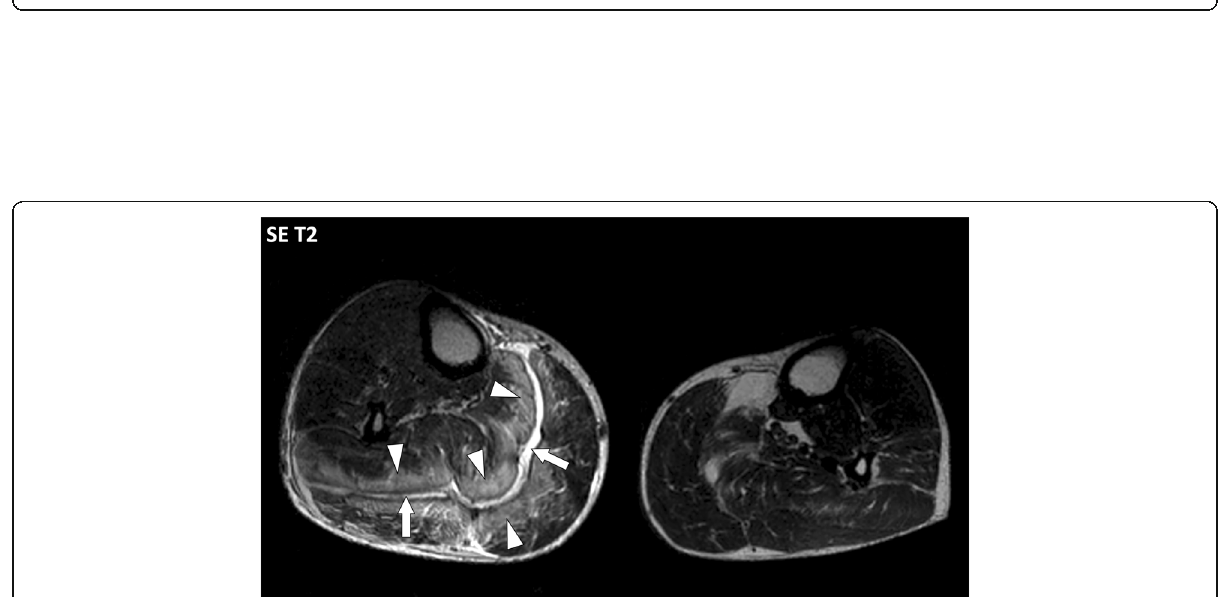
Fig. 11 Axial SE T2w image of the legs of a 71-year-old male with necrotizing fasciitis of the right leg. MRI demonstrates thickening of the deep intermuscular fascia between gastrocnemius and soleus muscles with fluid-like signal (arrows) and extensive infiltration of the connective tissue of the adjacent muscles